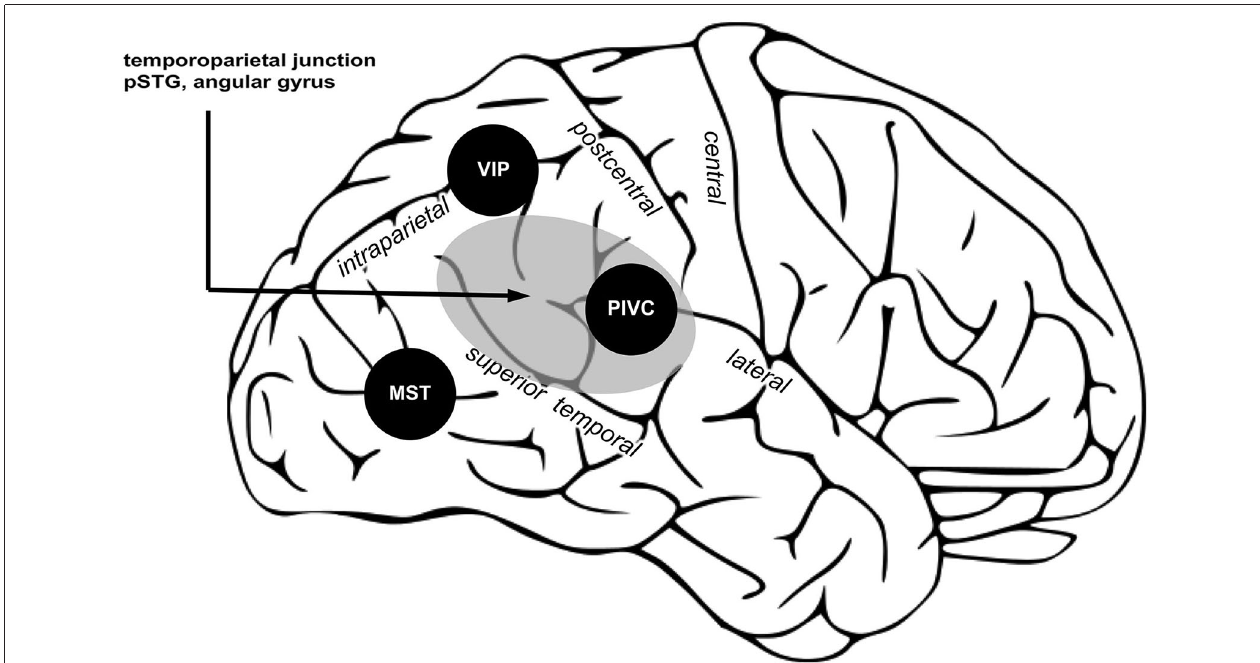
gray shows the TPJ, an area causally involved in encoding spatial aspects of bodily self-consciousness. Within TPJ, the pSTG and angular gyrus are regions associated to changes in spatial aspects of bodily self-consciousness in out-of-body experience and full-body illusion, and also the vestibular cortex region PIVC is part of the TPJ. (Image is a derivative of work licensed under creative